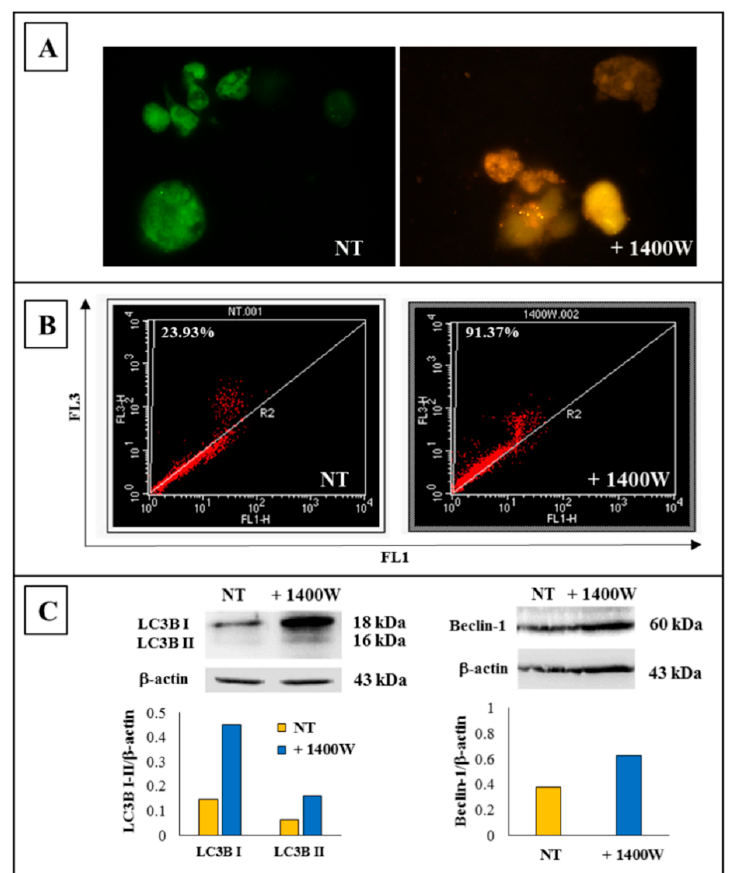
Figure 4. Detection of autophagy by acridine orange staining. ( A ) Representative images of acidic vacuolar organelles (AVO) fluorescence staining in not treated (NT), and 1400W-treated NS-forming cells (100 µ M for 48 h) (magnification 100 × ). ( B ) Flow cytometric analysis of AVO in NS-forming cells exposed or not to 1400W (100 µ M) for 48 h. AVO were measured using the 488-nm excitation detector (green fluorescence / FL1) and the 540-nm emission detector (red fluorescence / FL3). The results are representative of two independent experiments. ( C ) Representative images of western blot analysis of autophagic markers LC3B I / II and Beclin-1 in NS treated or not with 1400W (100 µ M) for 48 h are shown. The results of densitometric analysis of bands expressed as ratio vs β -actin band intensity are reported in the histograms. The results are representative of three independent experiments.